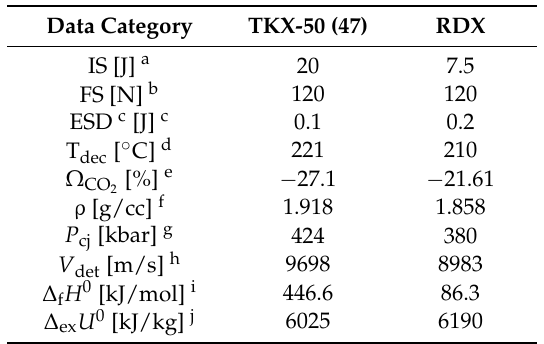
Table 6. Sensitivities and performance of TKX-50 and RDX.